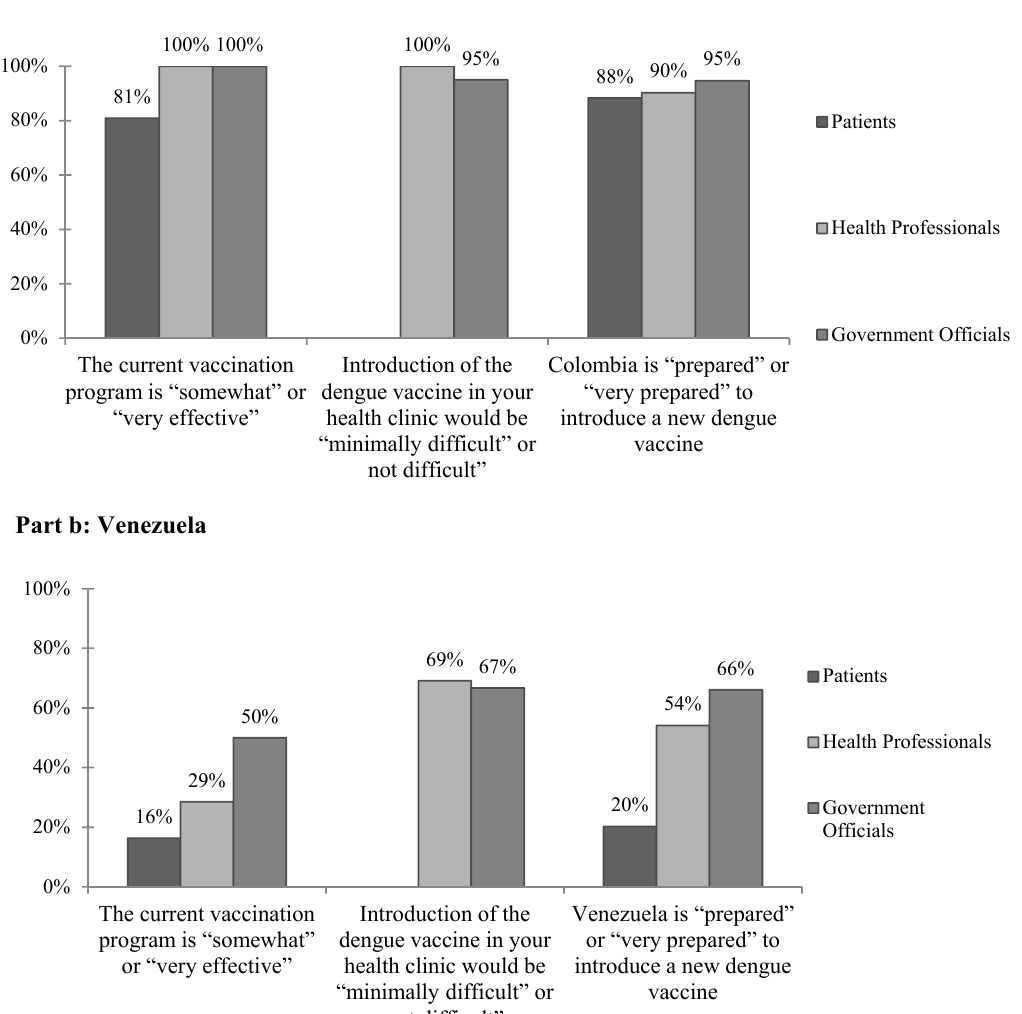
Figure 2. The subjective feasibility of vaccine introduction to ( a ) Colombia and ( b ) Venezuela